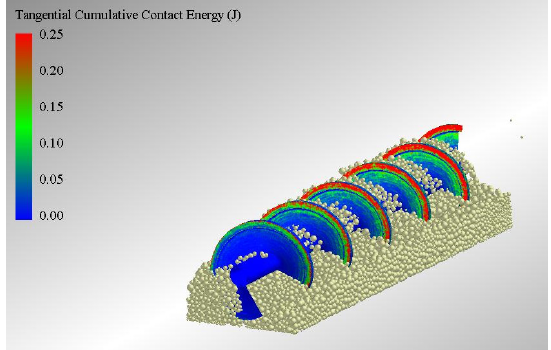
Figure 4. Wear form, ( a ) pin disc wear, ( b ) erosion wear.